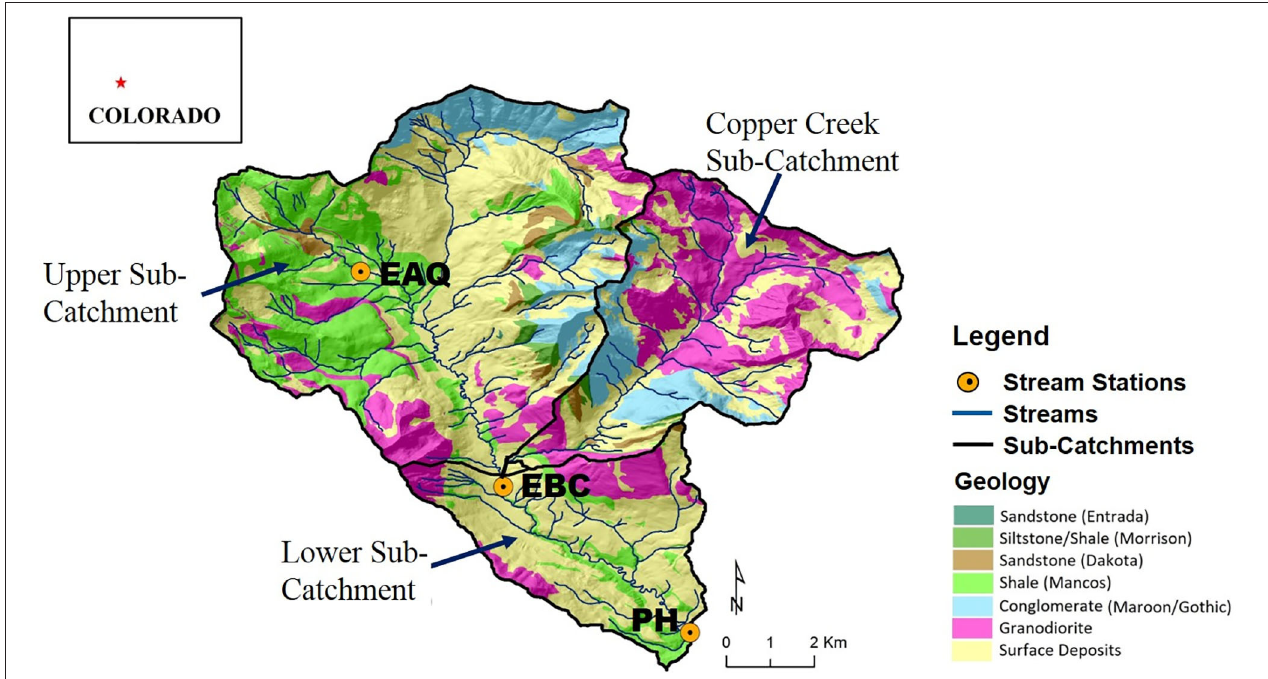
FIGURE 2 | Location of the East River Catchment, CO, USA overlain on a bedrock geology map showing the monitoring stations and the sub-catchments that are the focus of this study. The upstream reach is defined as the segment between EAQ and EBC, and the downstream reach is defined as the segment between EBC and PH. EAQ, East Above Quigley; EBC, East Below Copper; and PH, Pump House.